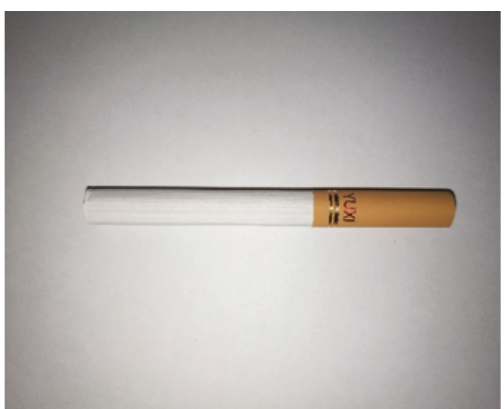
Figure 1: A cigarette with perforated tipping paper.